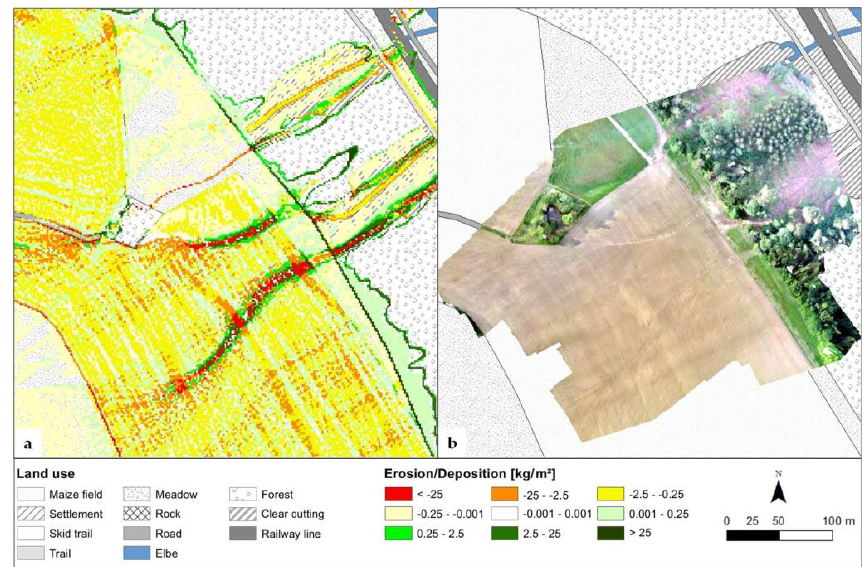
Figure 14. ( a ) The erosion risk map with the RZ-product for 31 May 2016 and ( b ) the UAV acquired orthophoto of the study site after the mud flows had occurred.